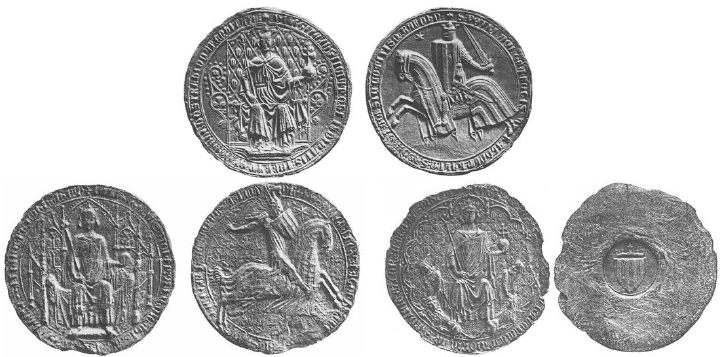
Figure 3. Seals of Peter IV. Above: 1337. Below: 1343–1344 and 1344. Published by De Sagarra, Sigil·lografia , nums. 57, 59, 58.